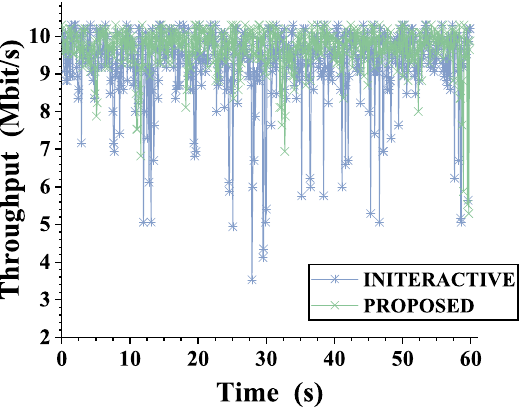
Figure 14. Comparison of bandwidth aggregation efficiency between the proposed scheme and the interactive scheme under multipath settings.